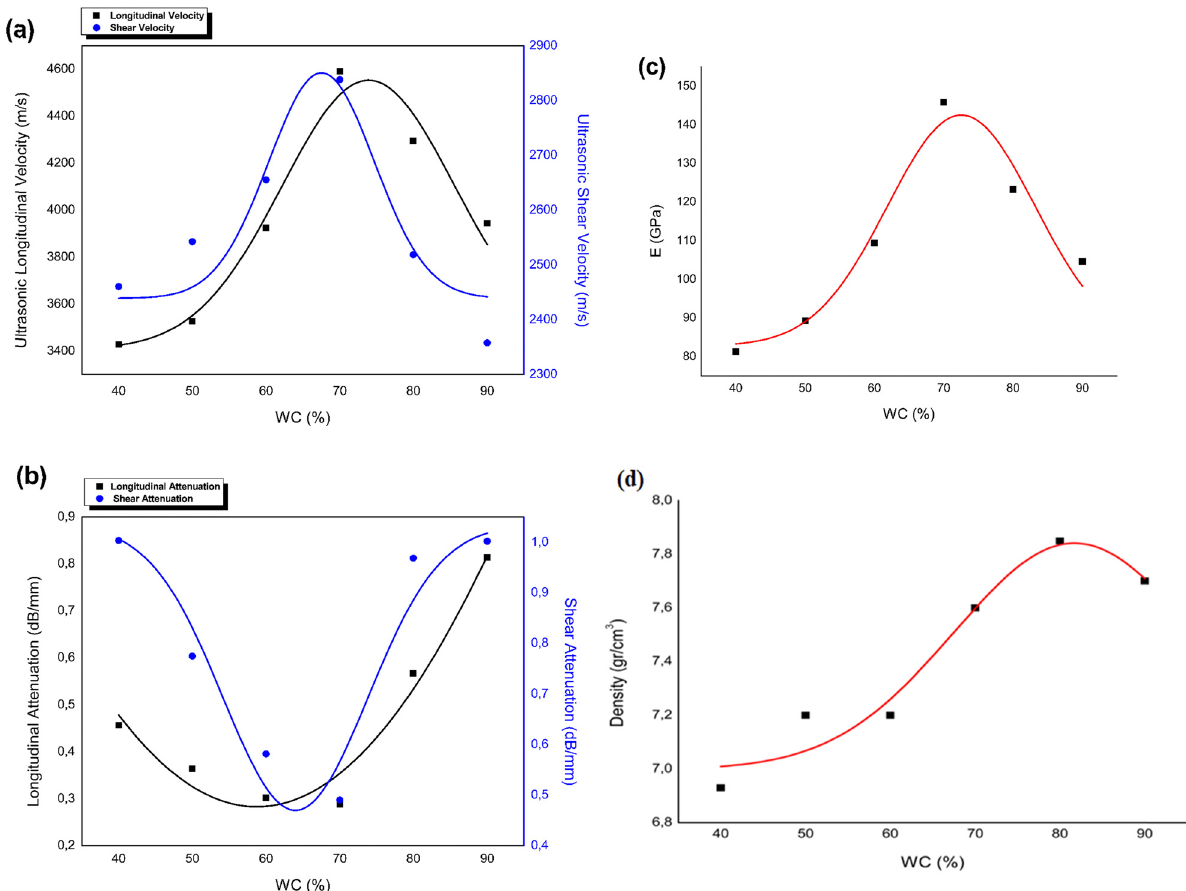
Figure 8: The relationship between the WC ( % ) values of the samples and ( a ) ultrasonic wave velocities, ( b ) ultrasonic attenuation, ( c ) elastic modulus and ( d )